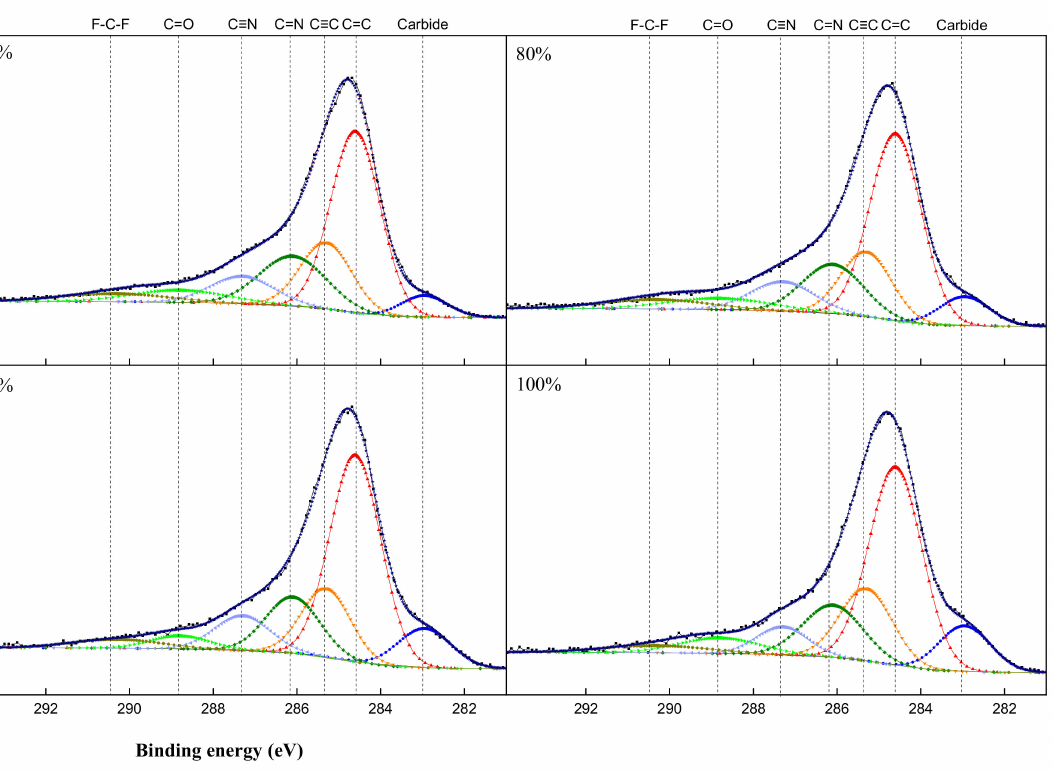
Figure 3. XPS C 1s spectra of carbon-doped SUS304 by laser